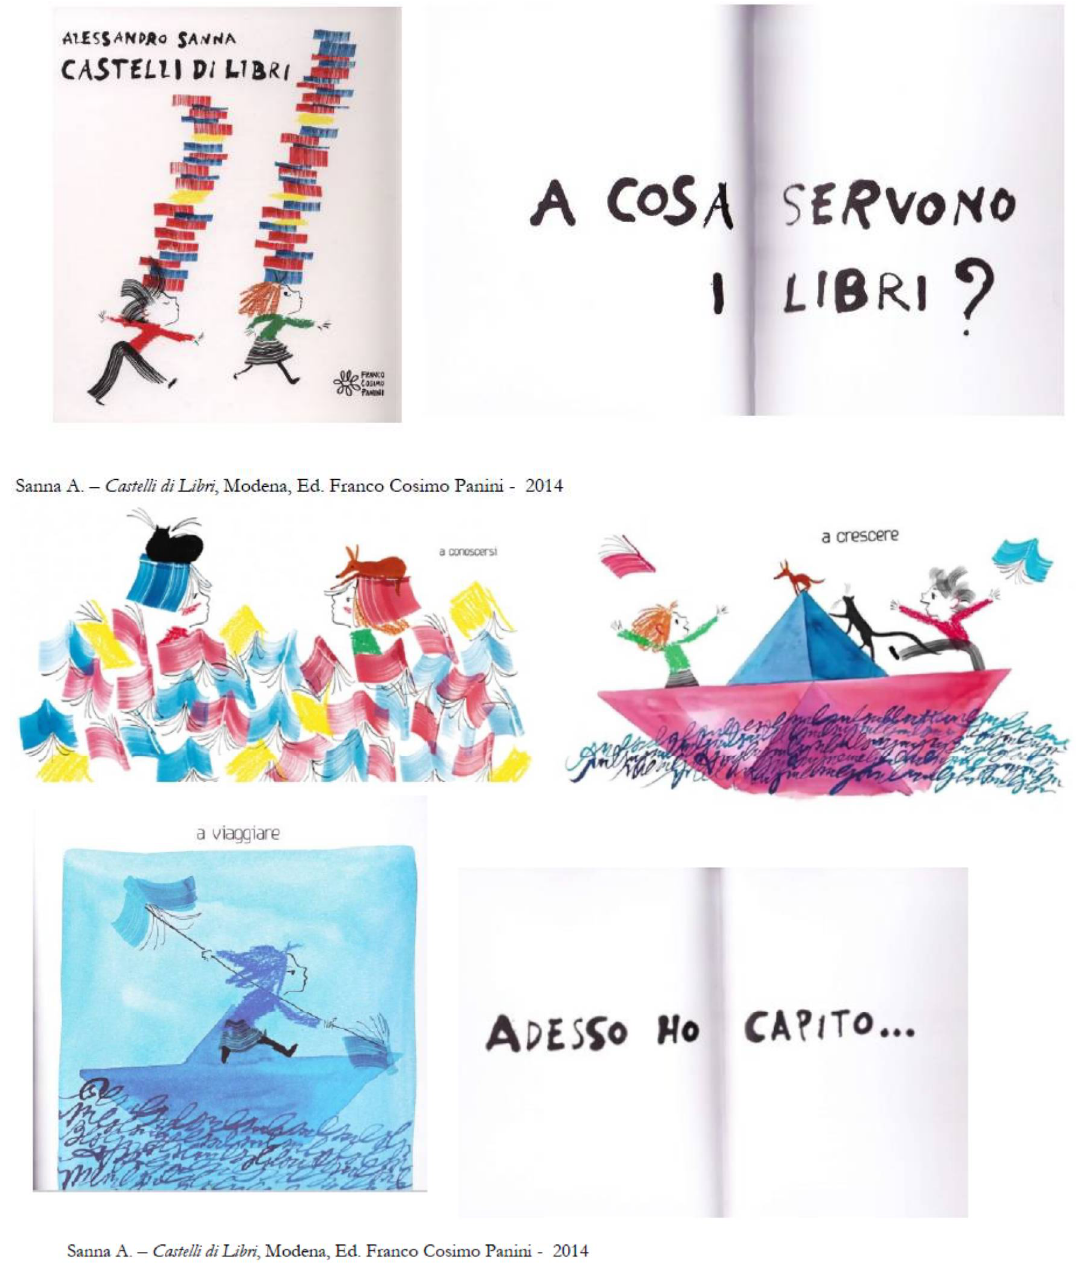
Figure A4. Sanna A.— Castelli di Libri , Modena, Ed. Franco Cosimo